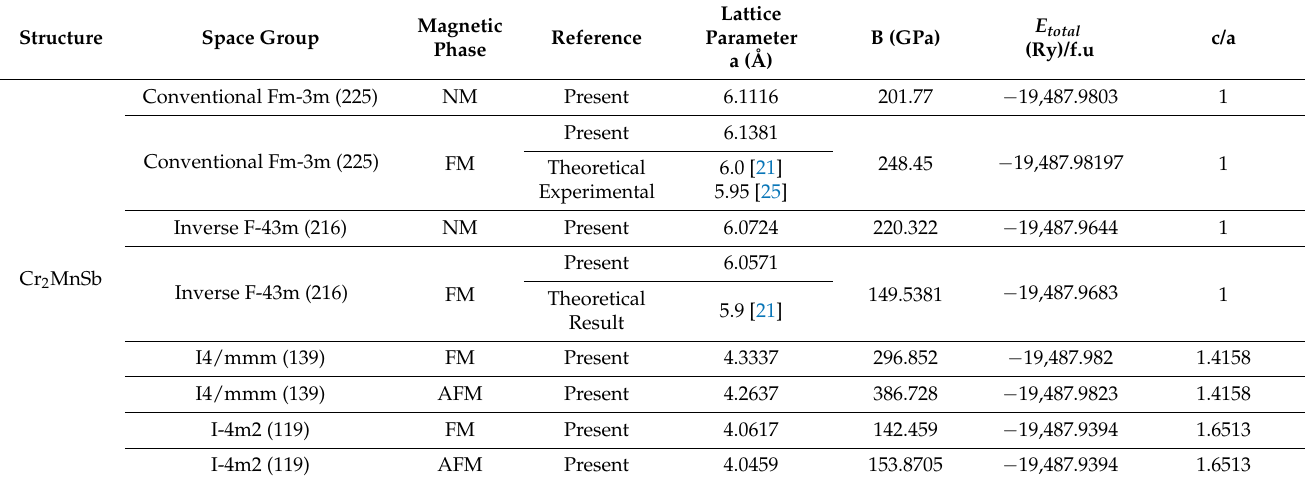
Table 2. Calculated lattice parameter (a), bulk modulus (B), and total energy (E tot ) for Heusler Cr 2 MnSb